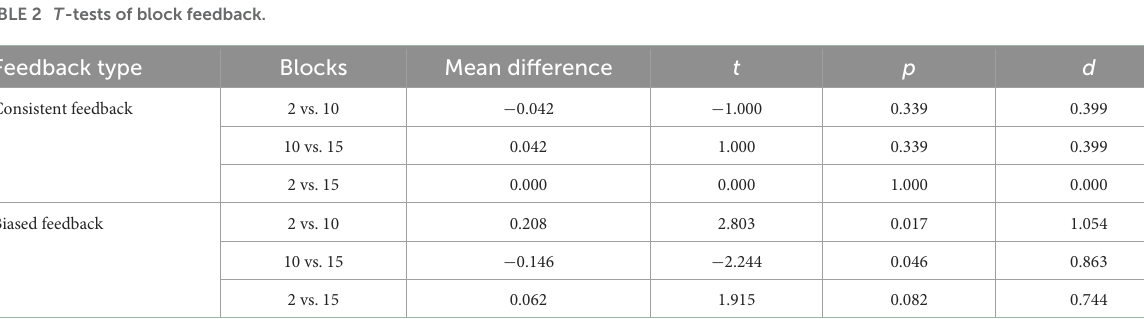
TABLE 2 T -tests of block